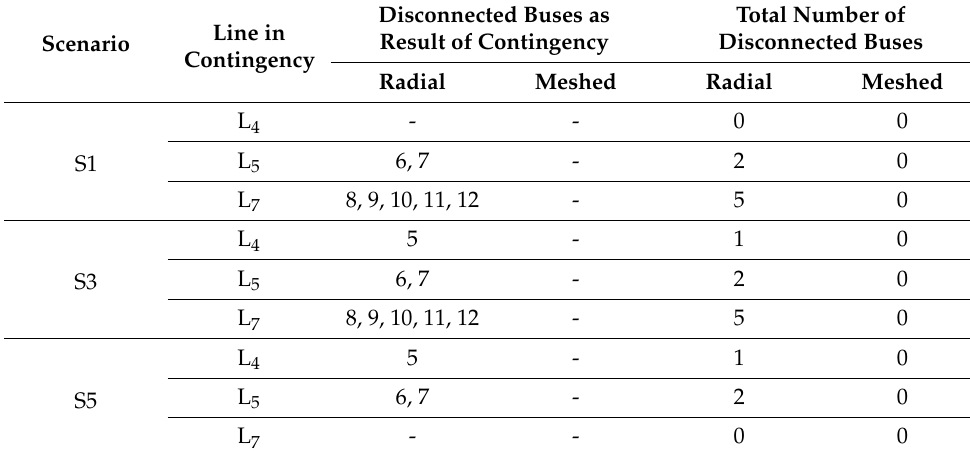
Table 4. 16-bus system, network security analysis under radial and meshed